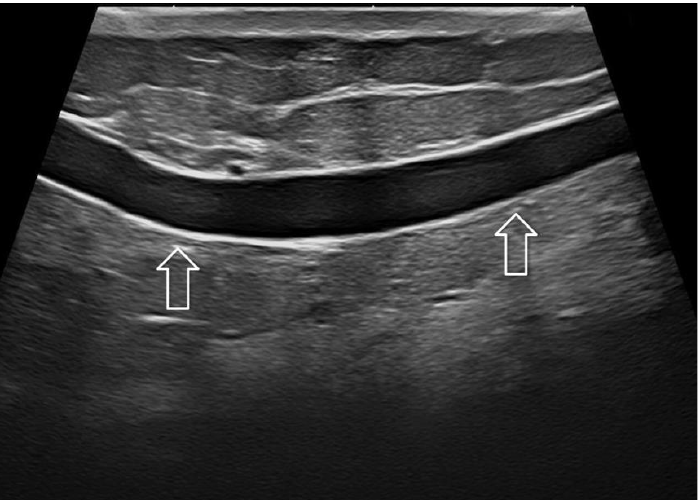
Figure 1. Breast vein imaged at 22 MHz. Note the high-quality details of the venous wall and lumen.